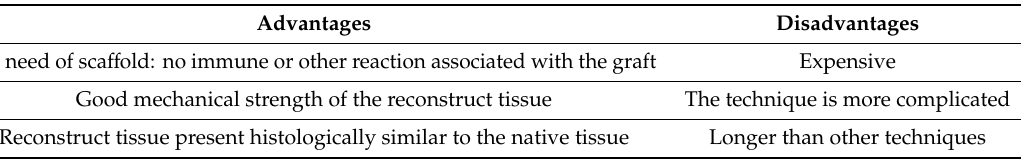
Figure 7. Types of tissues that can be reconstructed by tissue engineering using the self-assembly technique developed at LOEX. Table 3. Advantages and disadvantages of basic self-assembly techniques compared with common methods in tissue engineering.